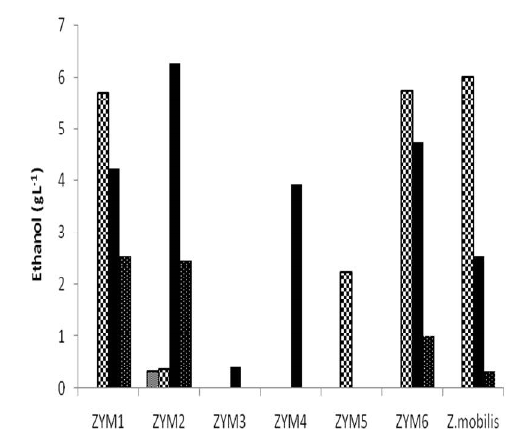
Fig 5. Effect of time on ethanol production by isolates.